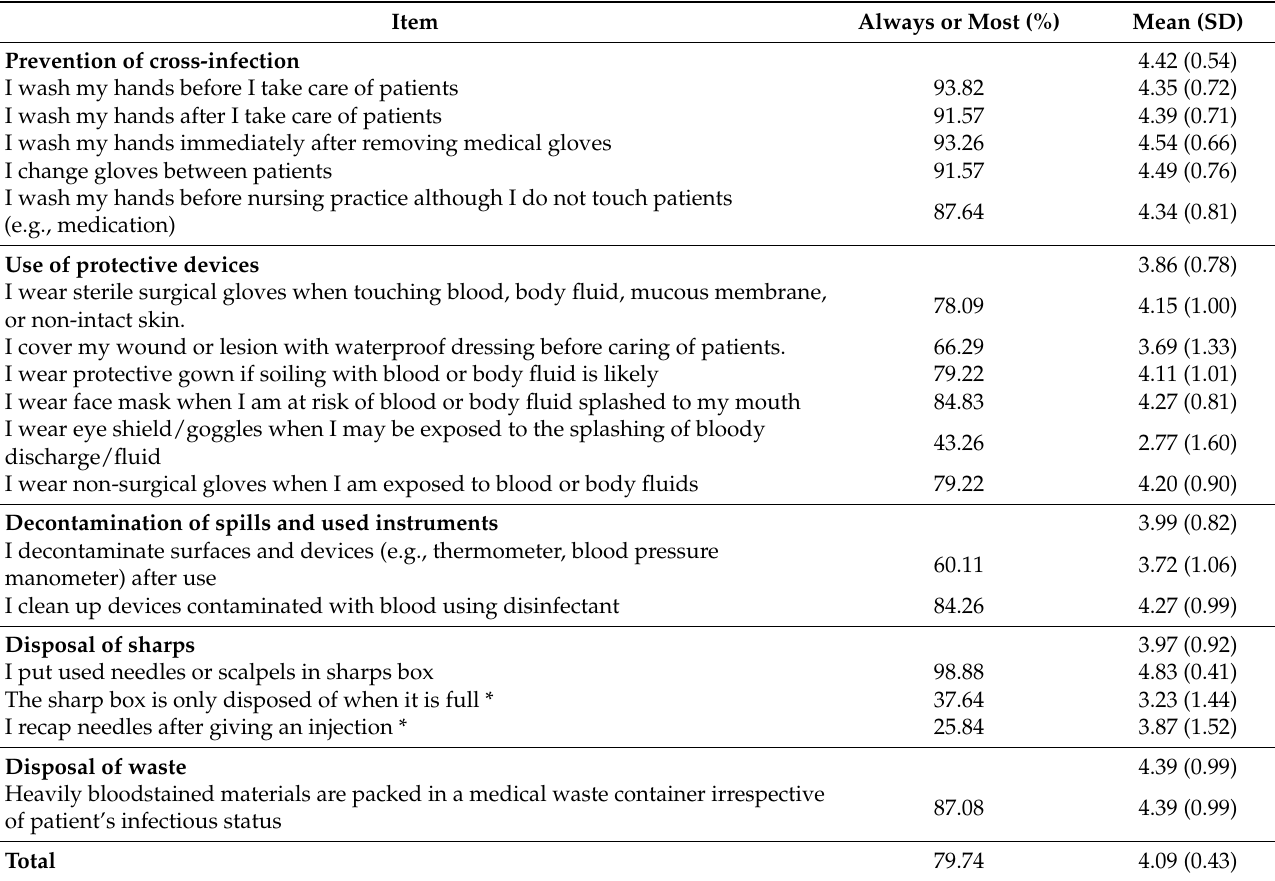
Table 3. Compliance with infection prevention and control practice ( n =